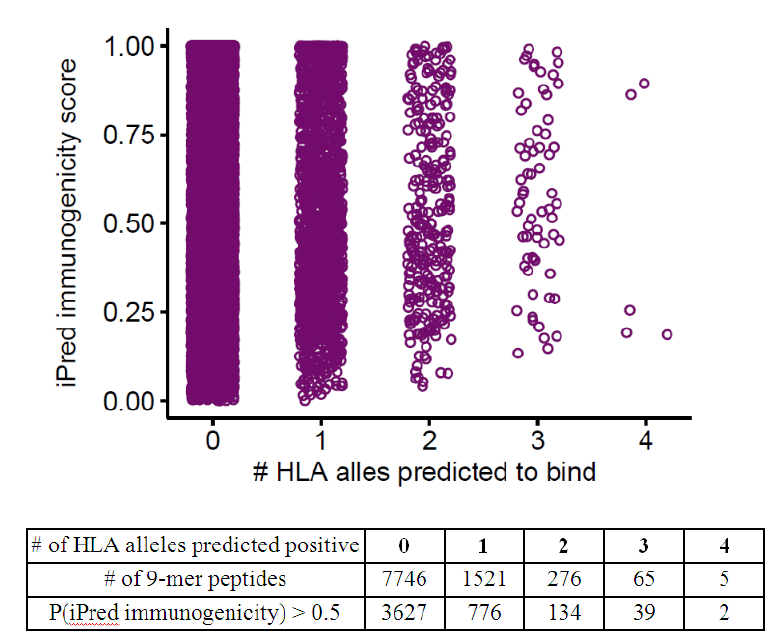
Figure 3. De novo search of 9-mer 2019-nCoV peptides with MHC presentation and immunogenicity potential. The MHC binding was predicted for HLA-A*02:01, HLA-A*01:01, HLA-B*07:02, HLA-B*40:01 and HLA-C*07:02 alleles by NetMHCpan 4.0 and immunogenicity was predicted by